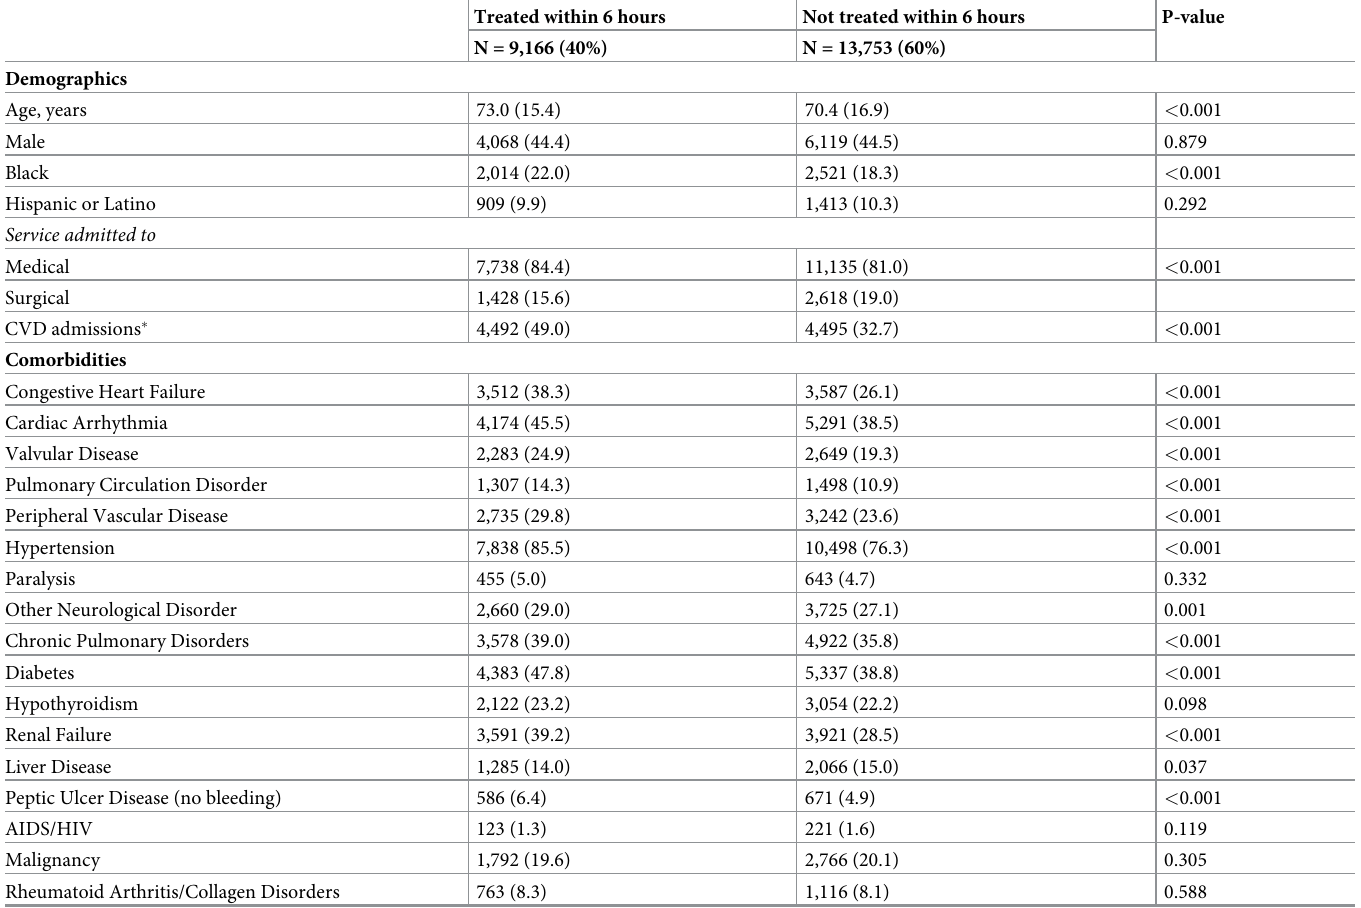
Table 1. Baseline characteristics of patients treated and untreated within 6 hours of developing severe inpatient hypertension. Treated within 6 hours Not treated within 6 hours P-value N = 9,166